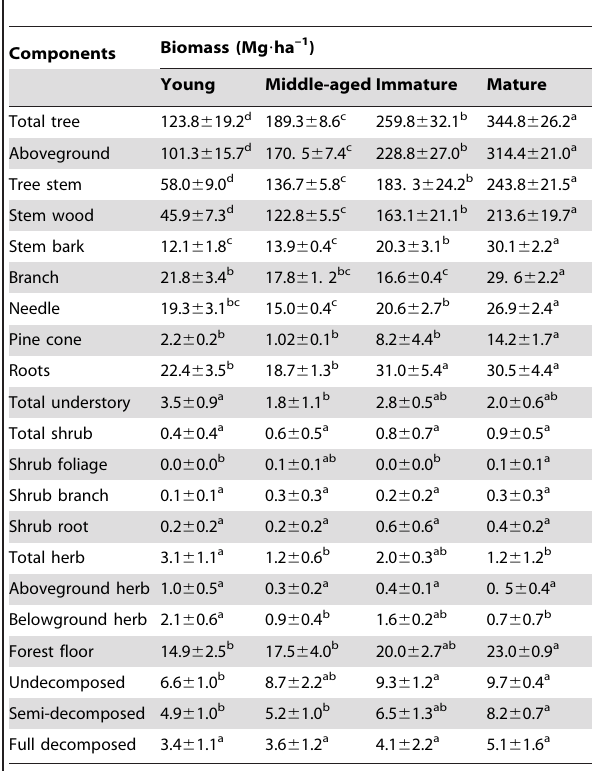
Table 3. Biomass of different ecosystem components in P. tabulaeformis